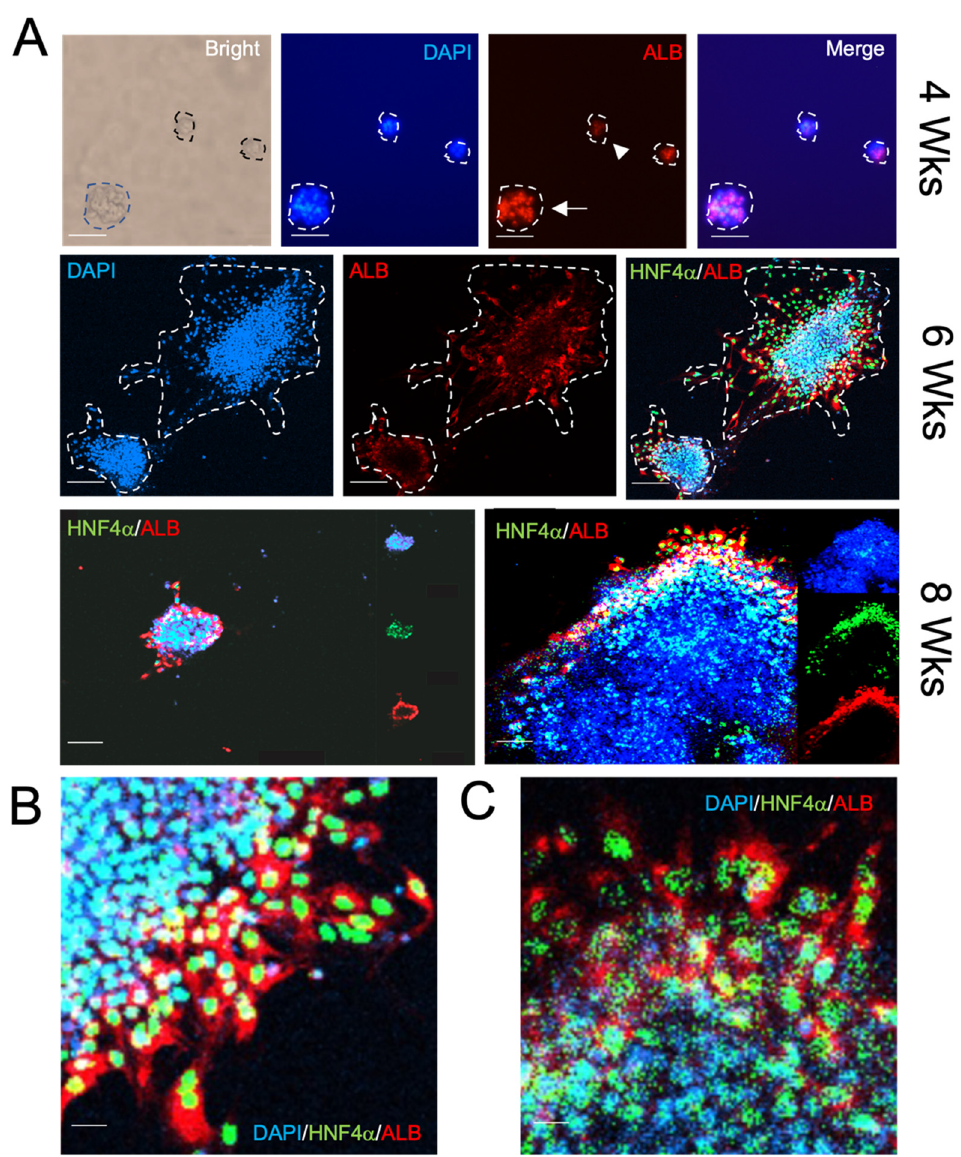
Figure 5. HepGOs show dynamic rates of expansion and expression of functional markers. ( A ) Representative IF images of HepGOs (white dotted line outlining each organoid) expanded for the indicated times. At 4 weeks, ALB staining in organoids (red) (arrow), while smaller cell structures (arrowhead) showed minimal or no staining. Note the expression of HNF4 α (green) and the functional marker ALB (red) over DAPI, the nuclear marker in blue, becomes localized to the periphery of larger organoids (right side vs. left side images of organoids at 8 weeks). ( B , C ) Higher power IF images showing HNF4 α and ALB-expressing cells within the peripheral area of HepGOs at 6 and 8 weeks, respectively. Scale bar is 100 µ m in A and 10 µ m in ( B , C